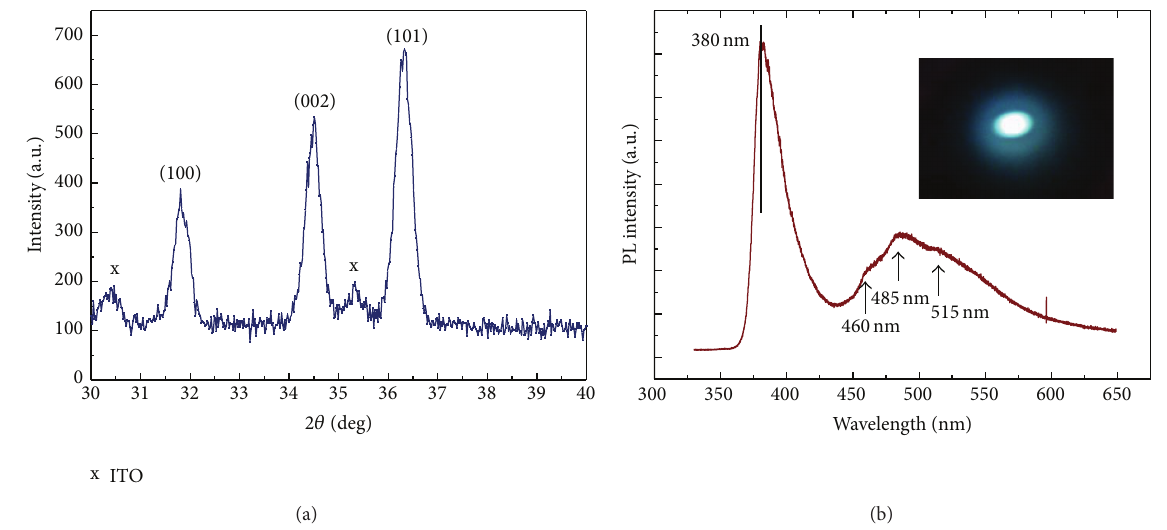
Figure 2: (a) XRD pattern and (b) RT PL spectrum of ZnO:YAG film on ITO/glass substrate deposited by ultrasonic spray pyrolysis. Inset shows photograph of photoexcited luminescence.